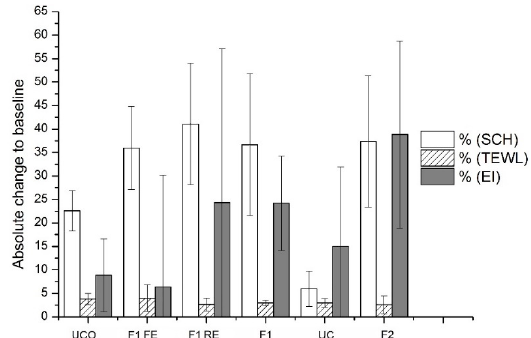
Figure 7. Skin irritation test—the influence of the investigated samples on in vivo measured skin parameters stratum corneum hydration (SCH), transepidermal water loss (TEWL), skin erythema index (EI) and both controls (under occlusion—UCO and without occlusion—UC); the results are shown as absolute changes of mean values on the second vs. first day, with the standard error of means; there were no statistically significant differences between the second vs. first day for any of investigated samples and controls.